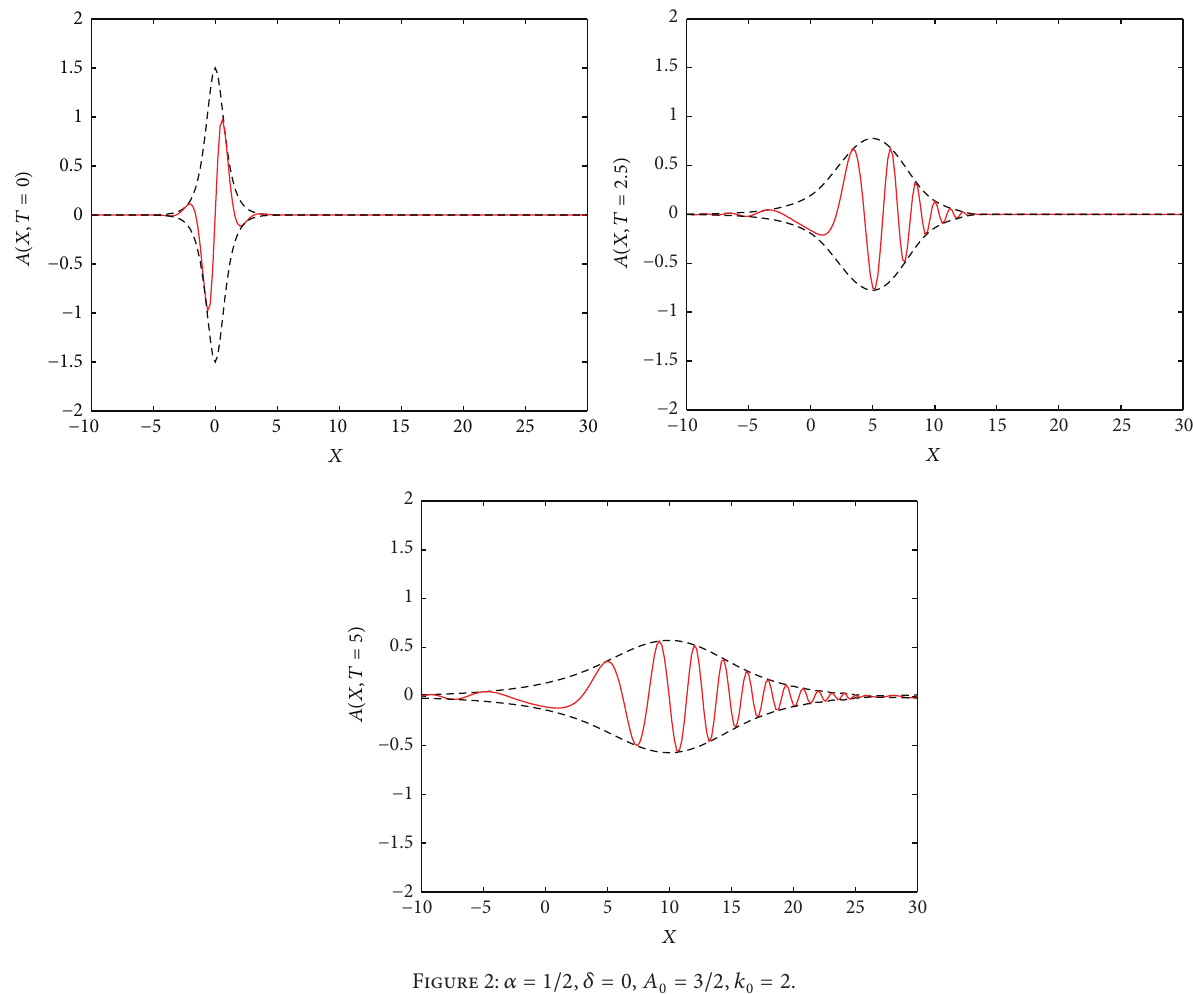
Figure 2: 𝛼 = 1/2 , 𝛿 = 0 , 𝐴 0 = 3/2 , 𝑘 0 = 2